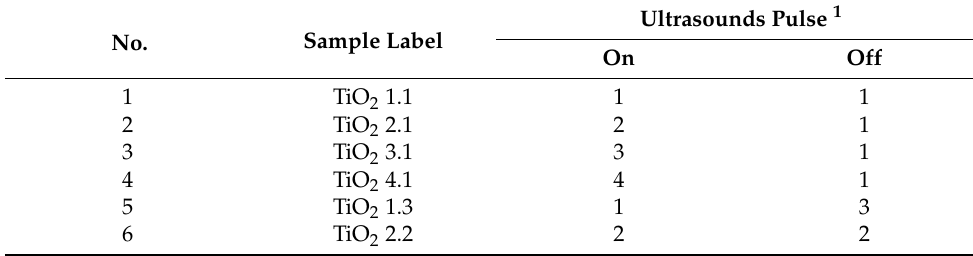
Table 4. Ultrasound pulse on/off ratios varied in the synthesis procedure of TiO 2 materials.